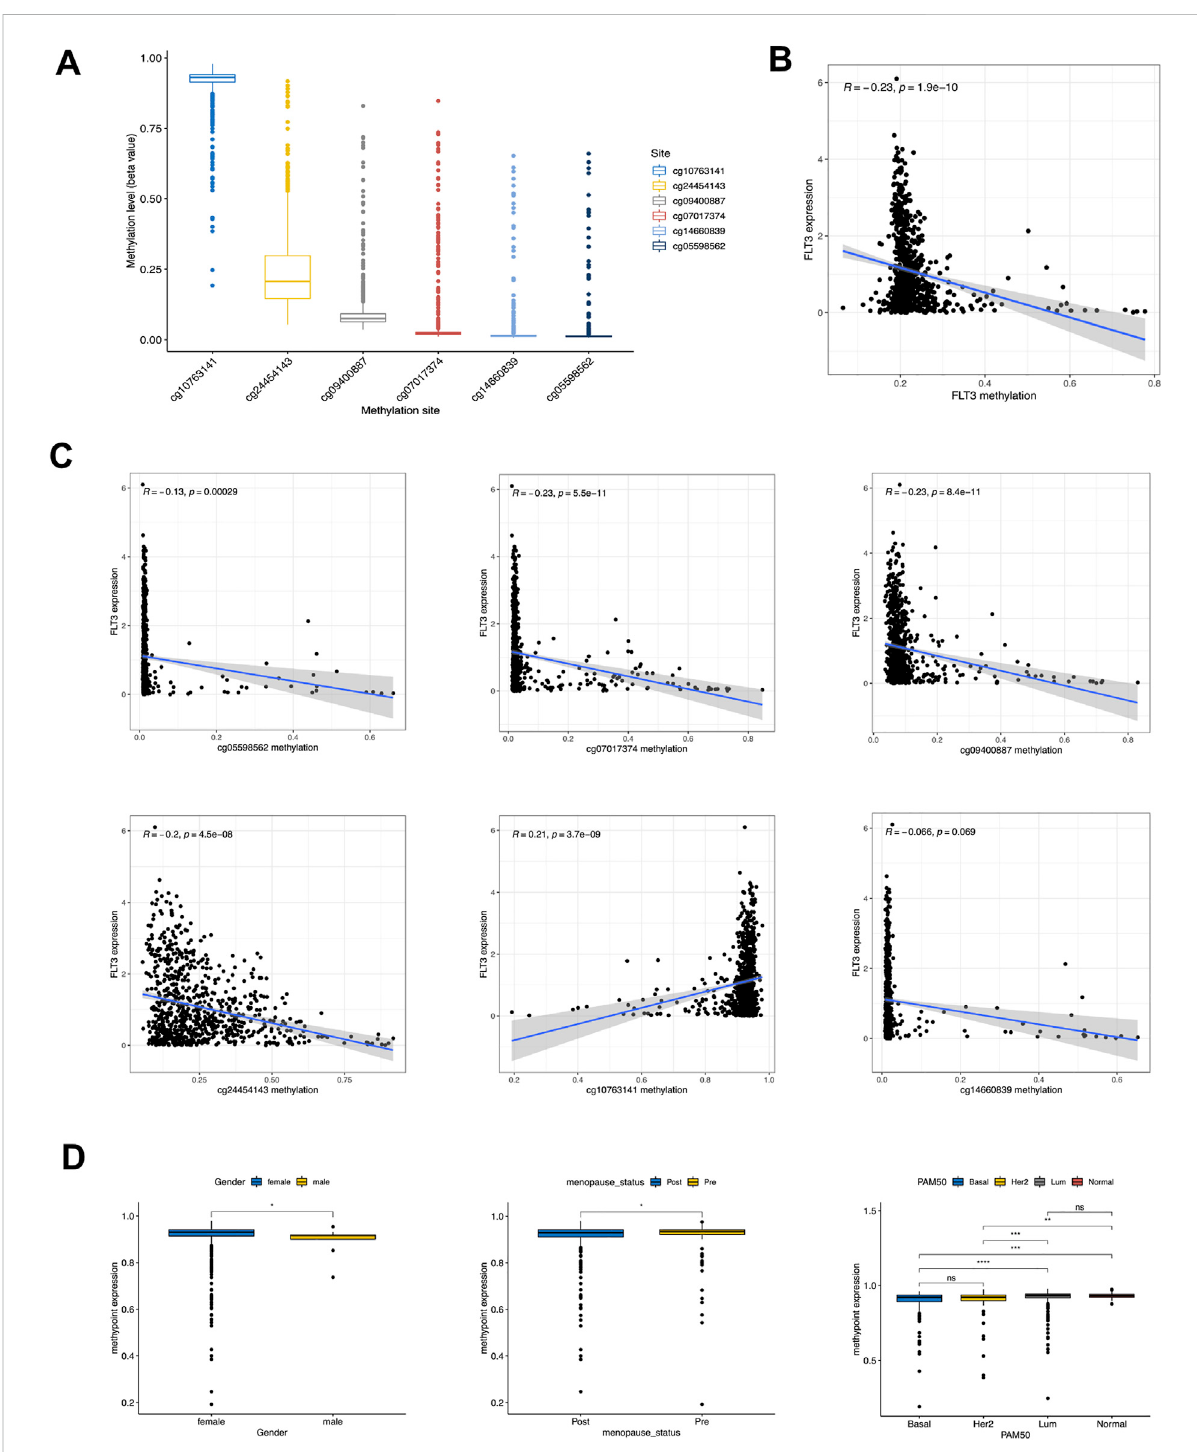
FIGURE 6 Correlation of DNA methylation level with FLT3 expression and clinical features. (A) Methylation level of 8 methylation site in FLT3. (B) Correlation of FLT3 expression with gross methylation level. (C) Correlation of FLT3 expression with different methylation sites (cg05598562, cg07017374, cg09400887, cg24454143, cg10763141 and cg14660839). (D) Methylation level of cg24454143 site was analyzed with gender, different menopausal status and PAM50 molecular subtypes. The asterisks represent the statistical p -value (ns: p > 0.05, * p ≤ 0.05, ** p ≤ 0.01, *** p ≤ 0.001, **** p ≤